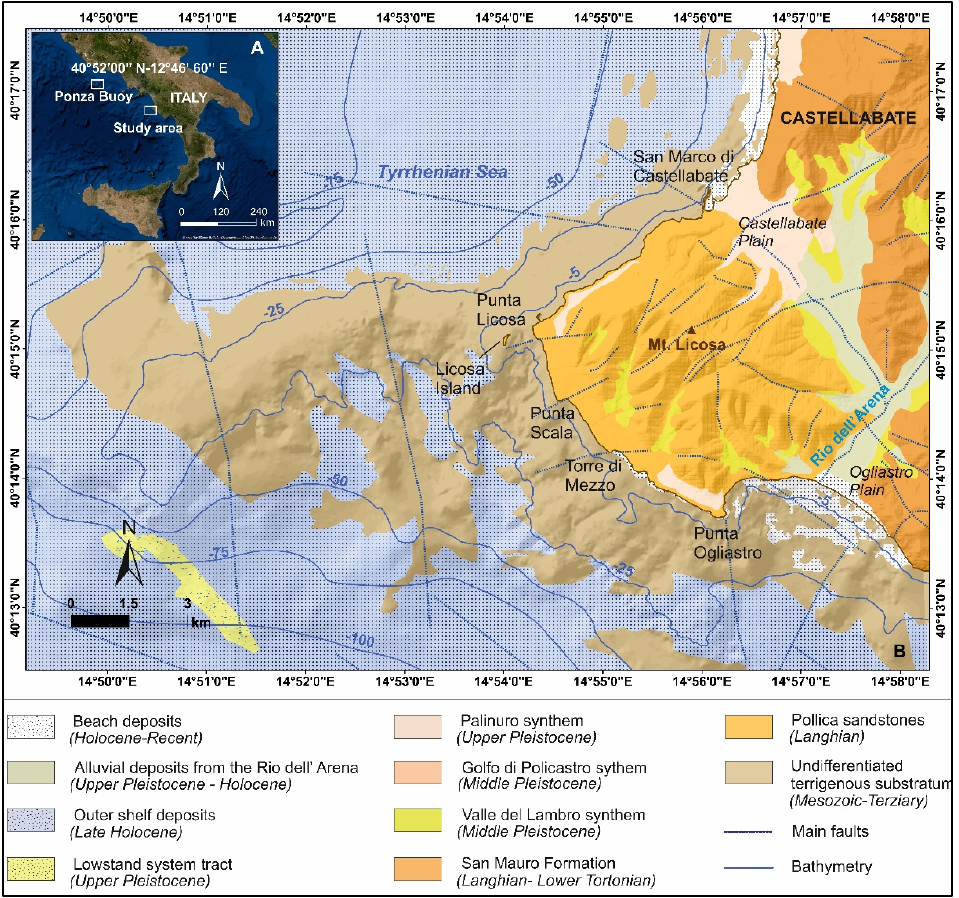
Figure 1. ( A ): Location map of the study area ( B ): geological map of the Punta Licosa promontory with the chronological classi fi cation of the main geological units (modi fi ed from Martelli et al. [45]). Pollica Sandstones and the San Mauro Formation belong to the Cilento Group [45] and are both constituted by arenaceous-pelitic turbidites. In particular, while Pollica Sand- stones have a main siliciclastic component, the San Mauro Formation is mainly character- ised by marly-calcarenite composition with conglomeratic intervals [46,47].